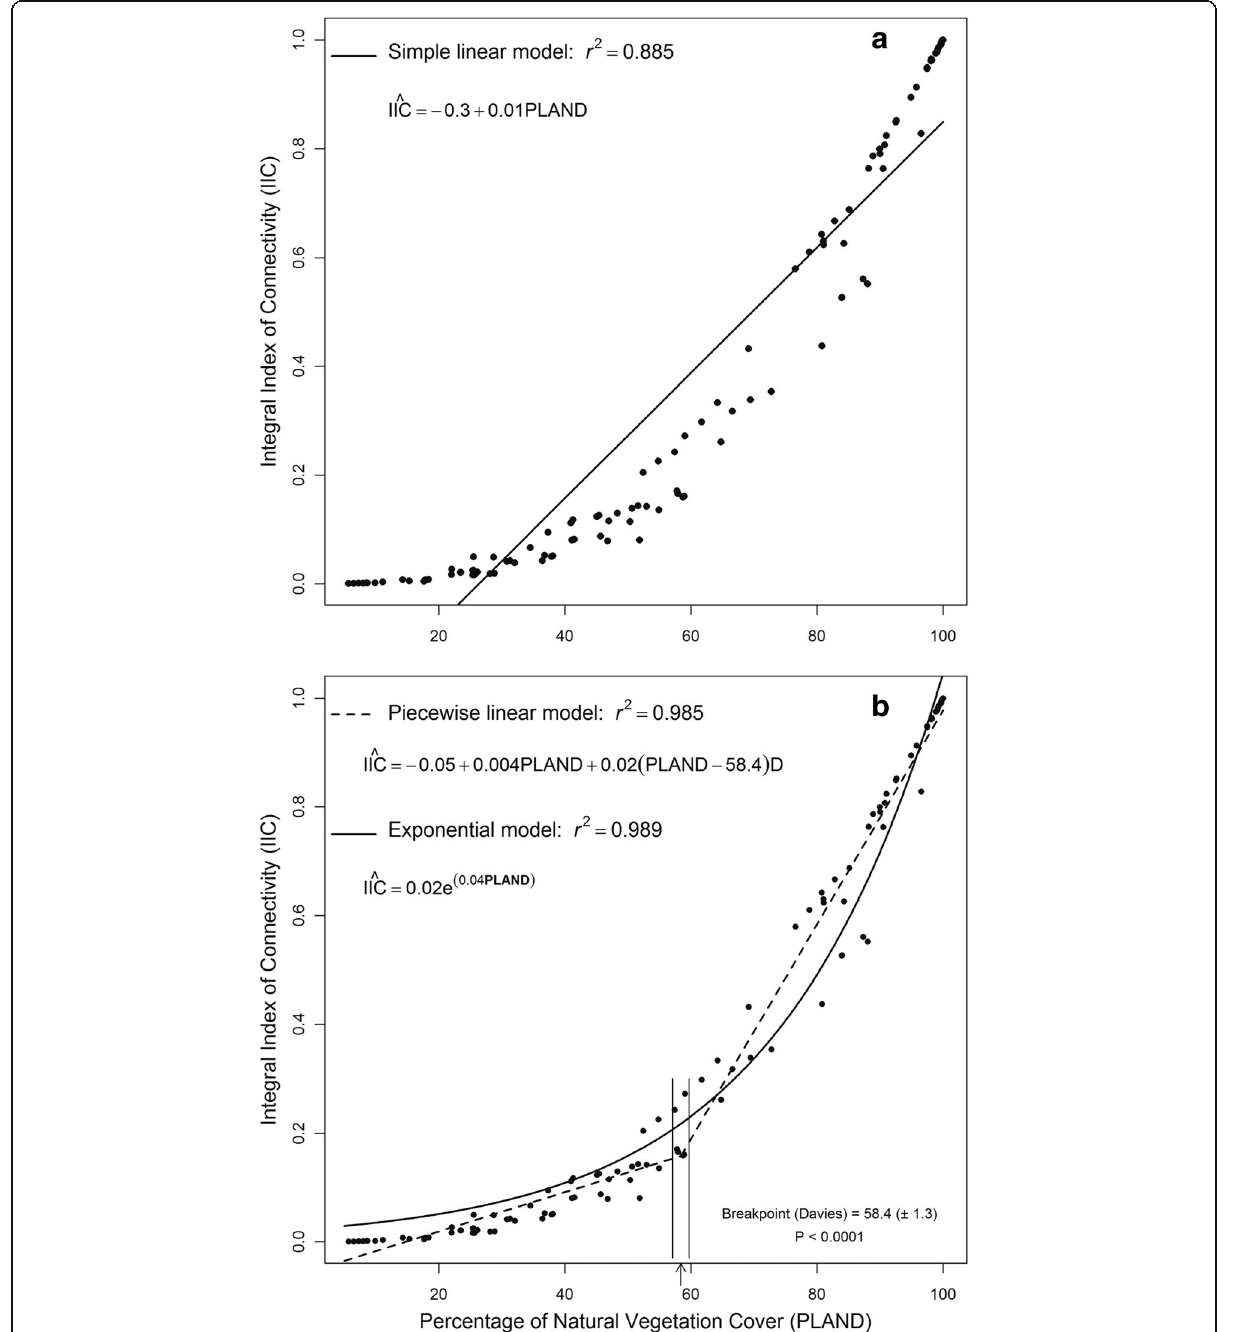
Fig. 3 Relationship between the percentage of natural vegetation (PLAND) and integral index of connectivity (IIC). Straight line represents the estimated regression equation based on a simple linear model ( a ). The dashed lines represent a piecewise linear regression model (where C =58.4 is the threshold point and D is a dummy variable with D =0 for C <58.4 and D =1 for C ≥ 1), and the vertical arrows represents the breakpoints identified using the Davies test (with±se) ( b